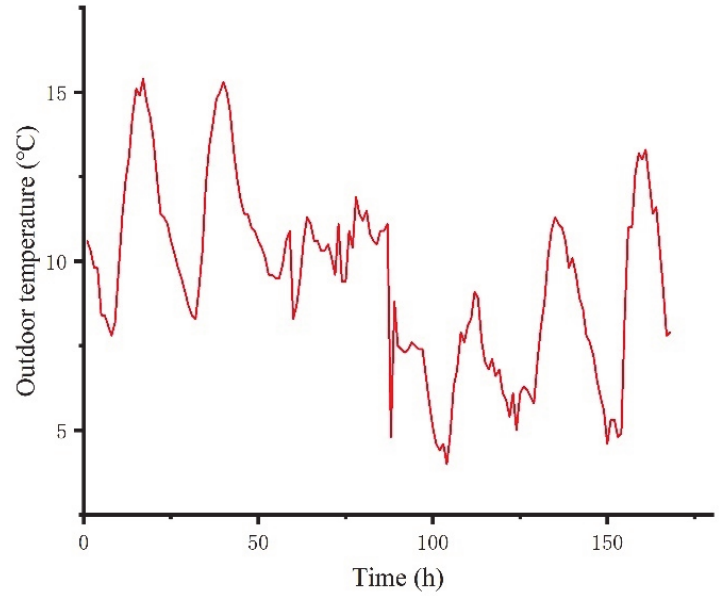
Figure 9. Hourly outdoor temperature.